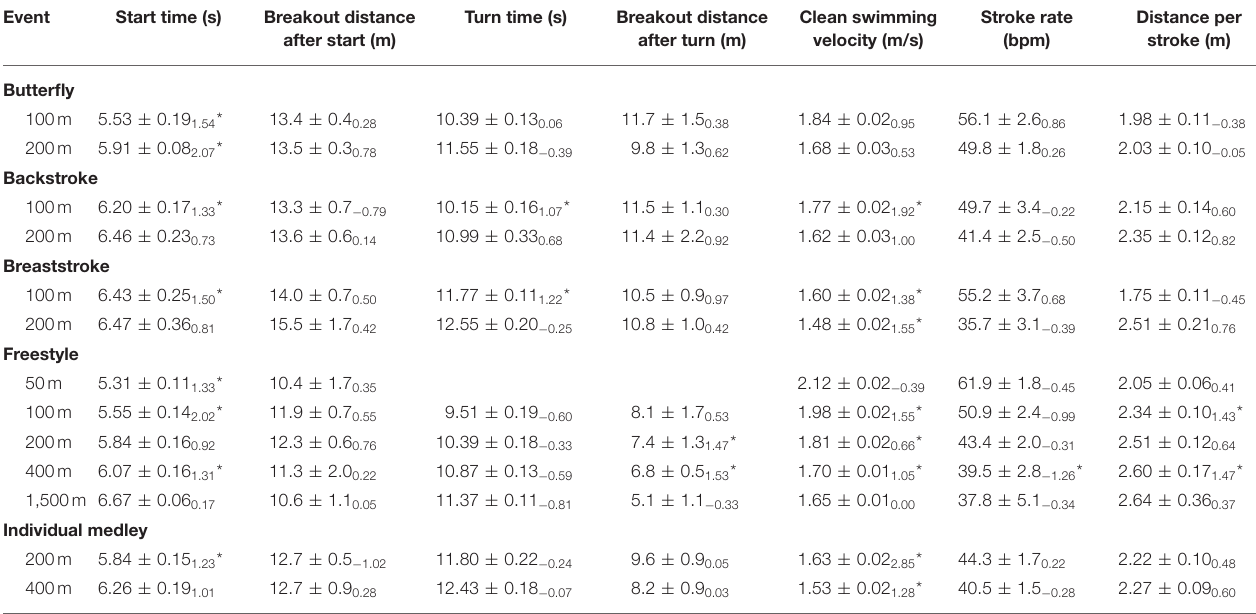
Positive and negative effect sizes in subscript font indicate improved or decreased performance, respectively.